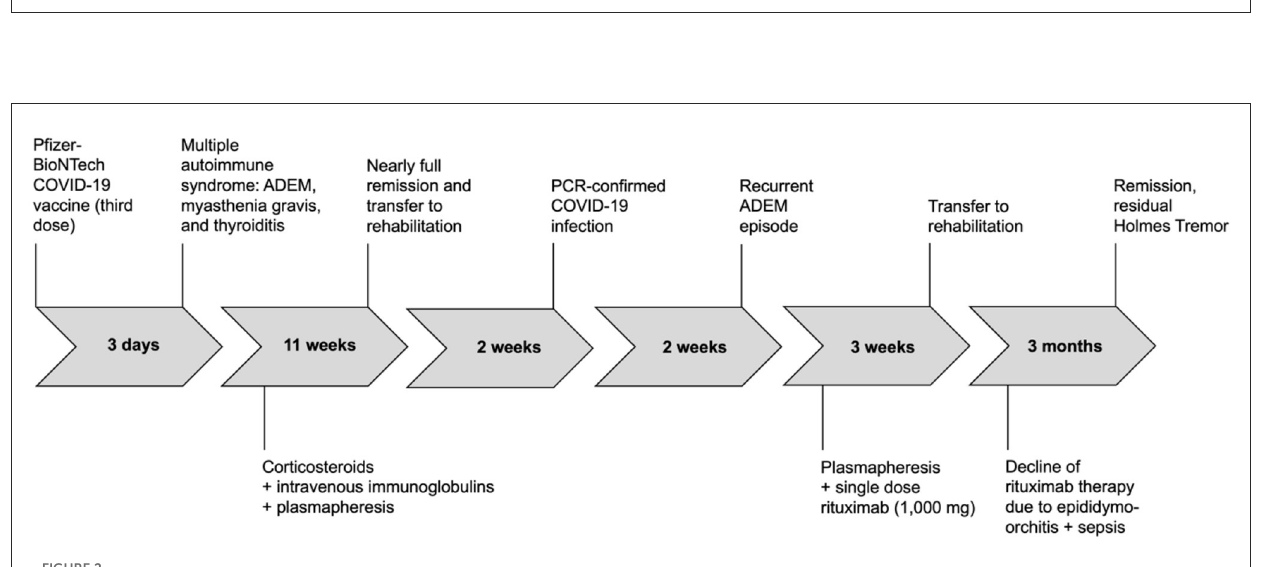
FIGURE2 Timeline of clinical events and